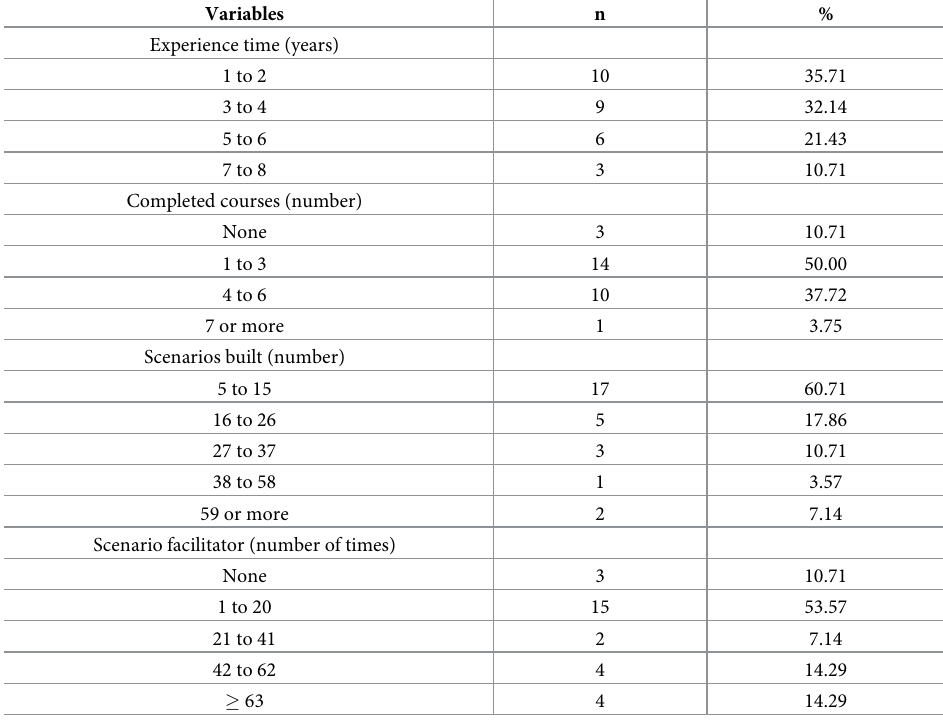
Table 5. Distribution of participants according to professional experience in the use of the healthcare simulation technique (n = 28). Sao Paulo, SP, Brazil